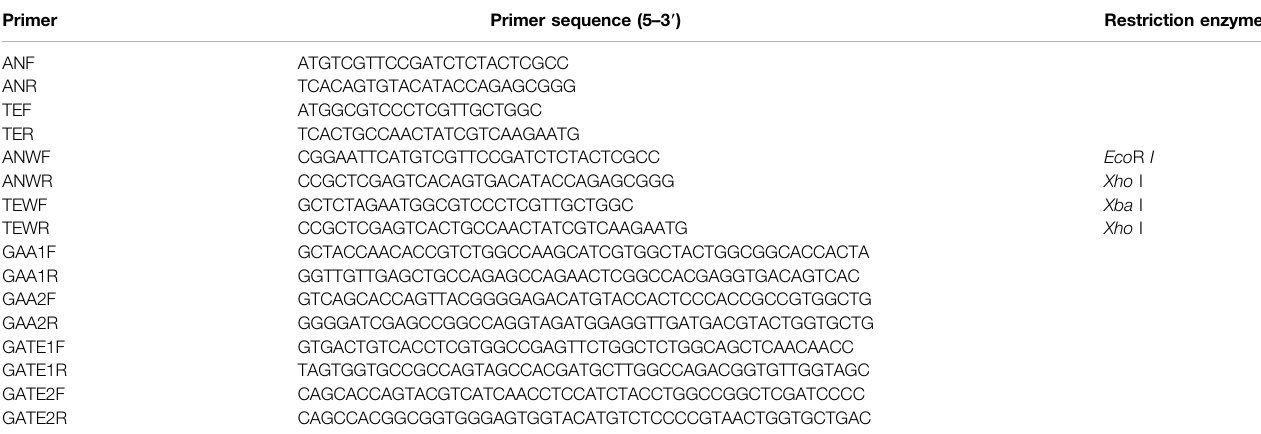
TABLE 1 | Sequences of the primers used for this research.